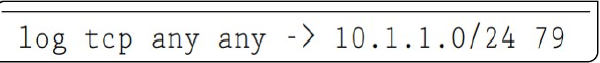
Figure 11. Simple SNORT rule extracted from SNORT website [58].